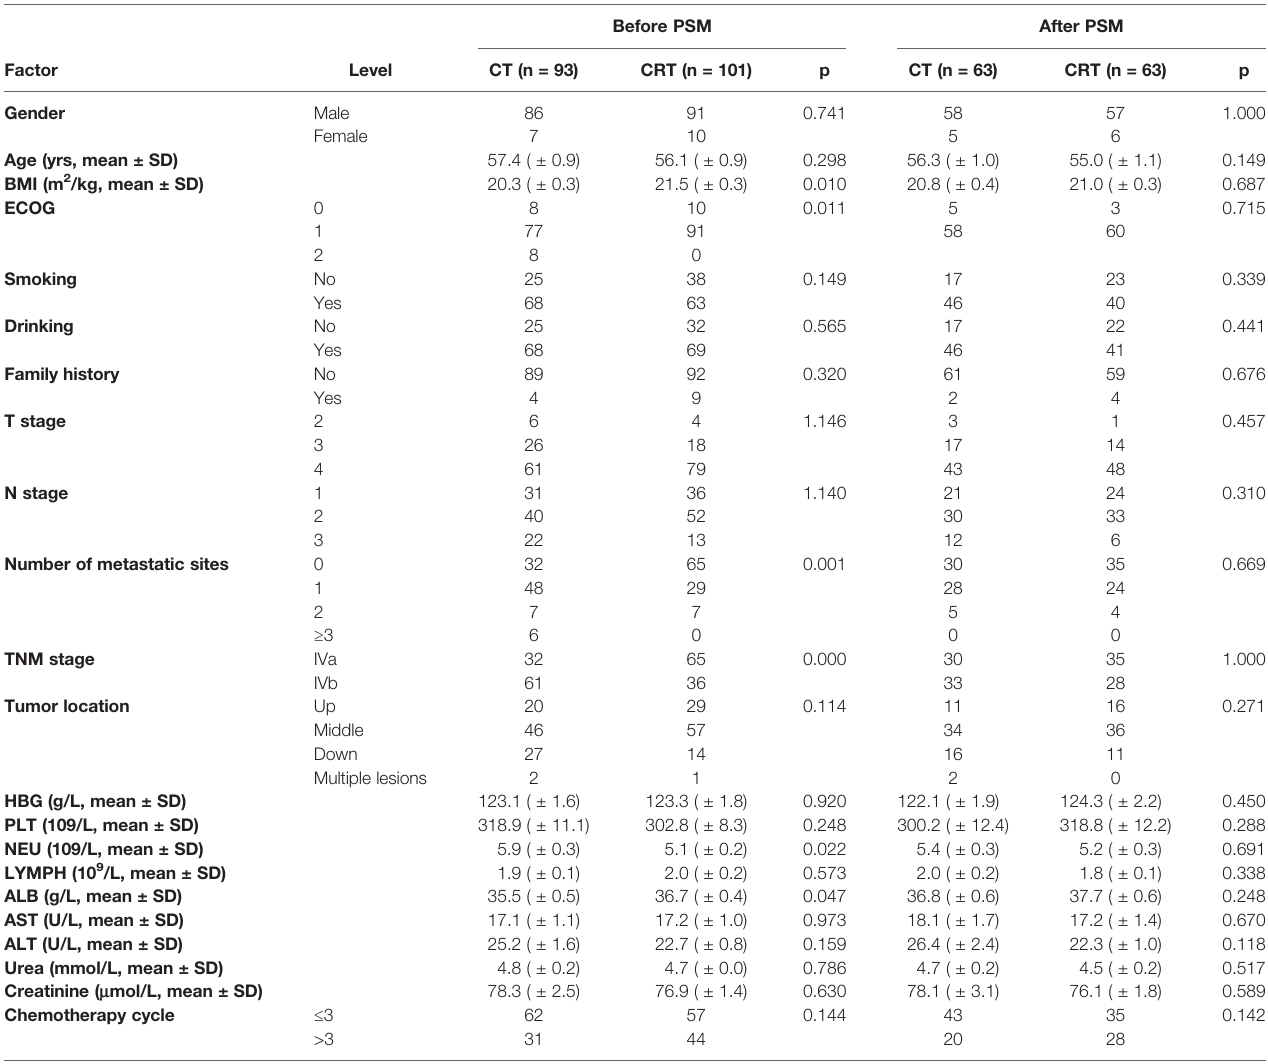
TABLE 1 | Patient characteristics before and after PSM in the CRT and CT alone groups.